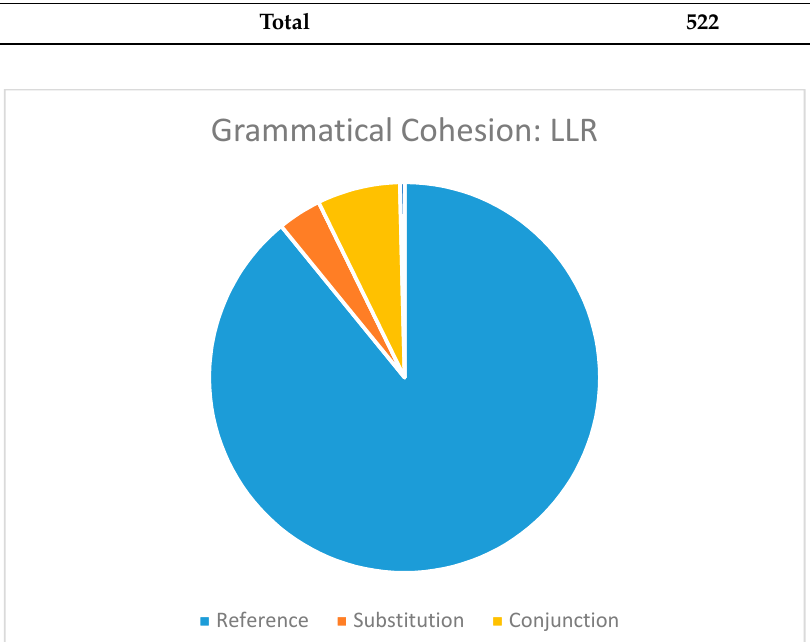
Figure 3. Grammatical cohesion.